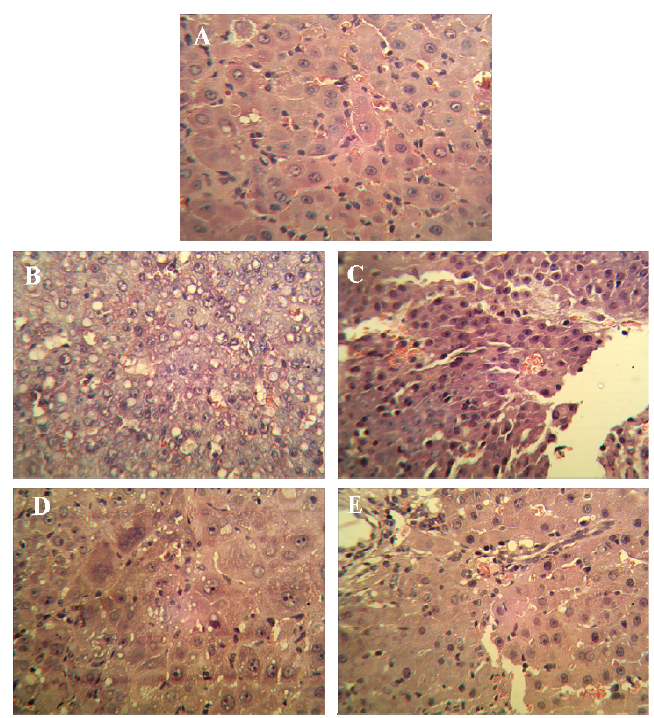
Figure 1. H&E-stained liver tissue biopsies from rats by experimental group (magnification factor × 400). ( A ) normal control group; ( B ) tumor control group; ( C ) low-SJAMP-dose group (17.5 mg/kg); ( D ) medium-SJAMP-dose group (35 mg/kg); ( E ) high-SJAMP-dose group (70